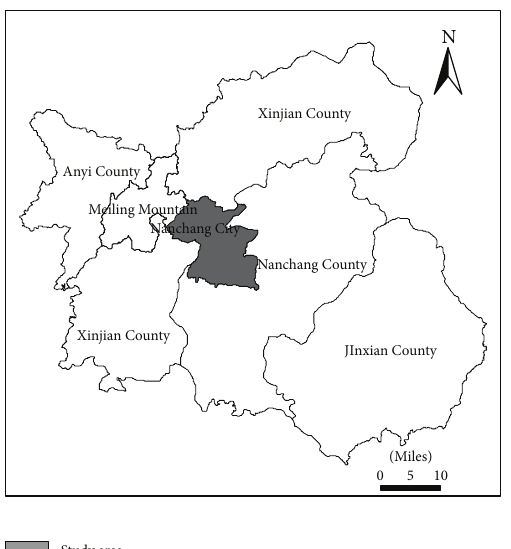
Figure 3: Sketch map of study area (the accurate administrative division data provided by Nanchang Meteorological Bureau).